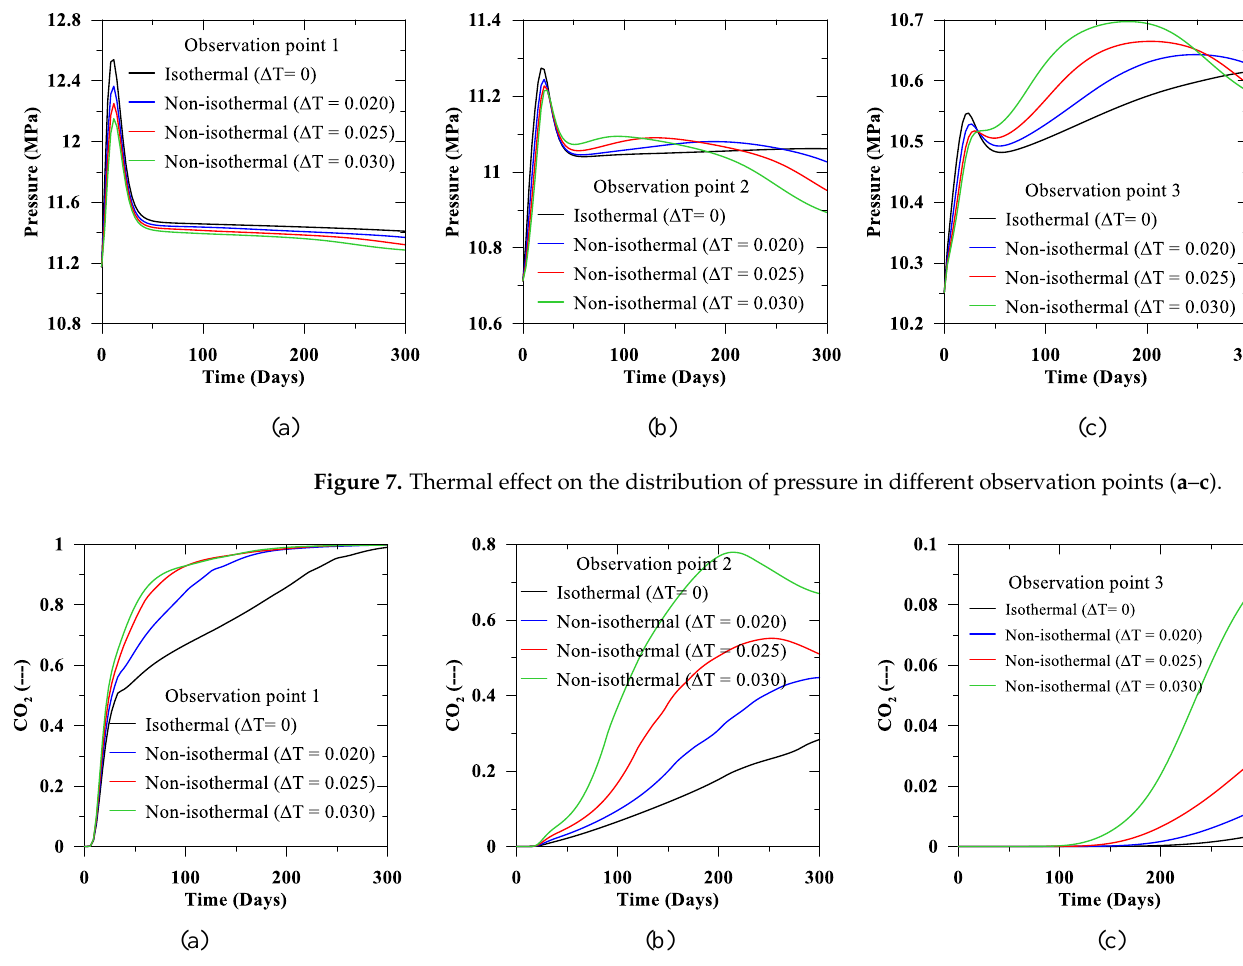
Figure 8. Thermal effect on the distribution of CO 2 mole fraction in different observation points ( a – c ).